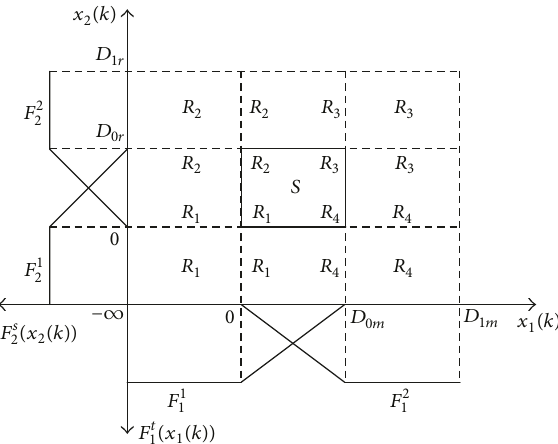
Figure 2: The sketch map of the fuzzy membership